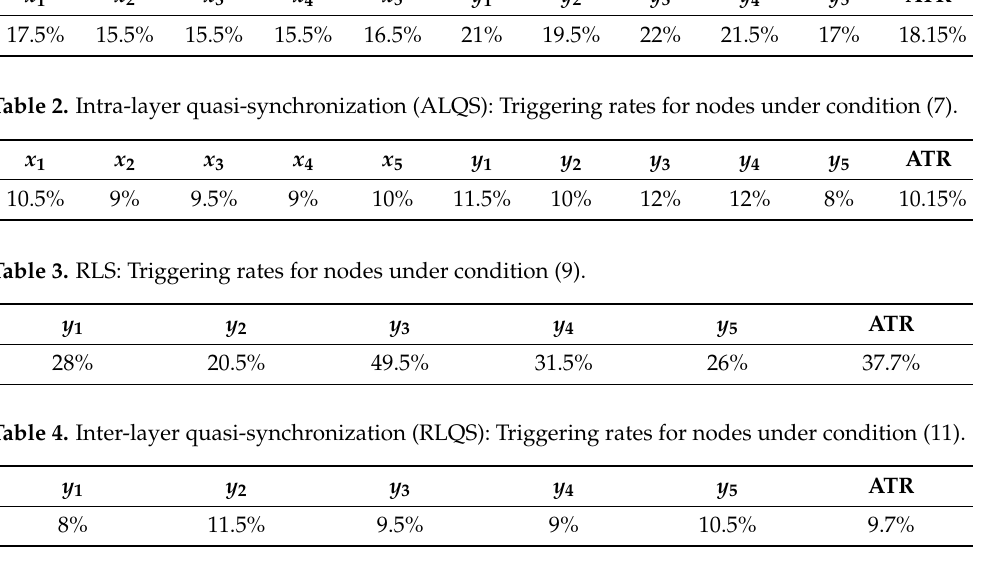
Table 1. ALS: Triggering rates for nodes under condition (3). x 1